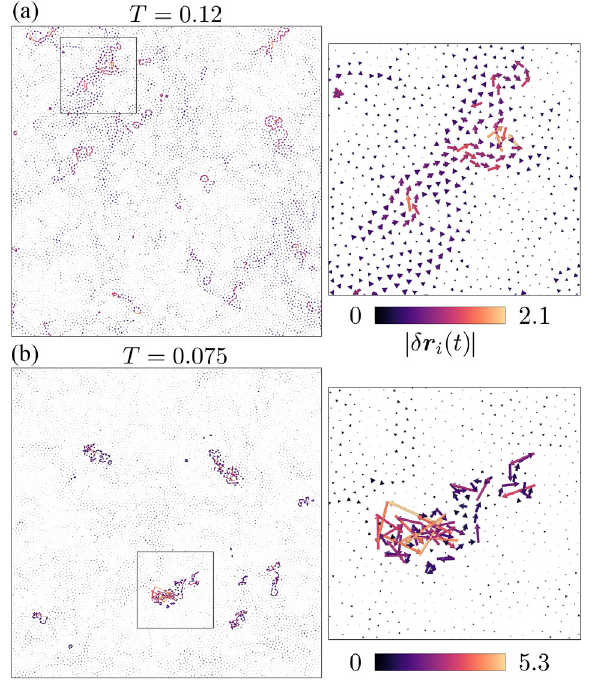
FIG. 8. Displacement field at early times. Displacement 0 . 12 and (b) T ¼ 0 . 075 corresponding fields at (a) T ¼ T MCT ¼ to the images in Figs. 5(b) and 5(c). Arrows show the particle 0 Þ at (a) t ¼ 2 × 10 3 , t Þ ¼ r t Þ − r displacement vectors δ r i ð i ð i ð (b) 3 . 2 × 10 8 . The linear size of the box is L ¼ 100 . Right: enlargement of the squared region; displacement vectors are colored by their